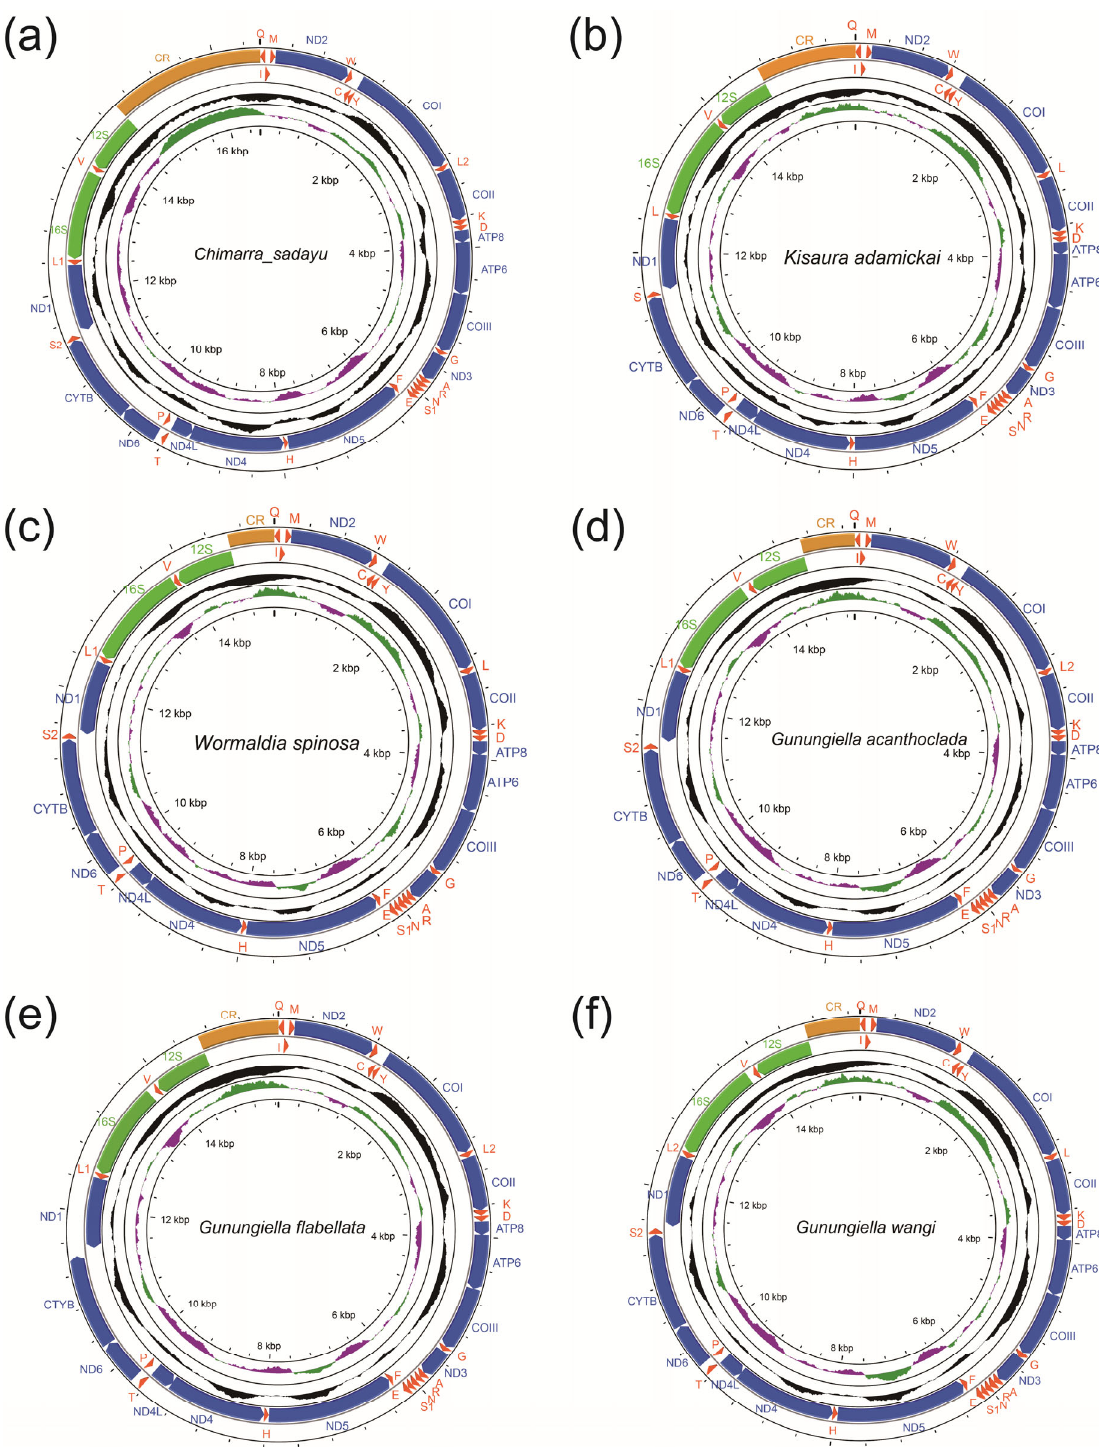
Figure 4. The mitogenome of six species of family Philopotamidae: ( a ) Chimarra sadayu ; ( b ) Kisaura adamickai ; ( c ) Wormaldia spinosa ; ( d ) Gunungiella acanthoclada ; ( e ) Gunungiella flabellata n. sp.; ( f ) Gunungiella wangi n. sp. The direction of gene transcription is indicated by the arrows. PCGs are indicated in blue, tRNA in red orange, rRNA genes in green, and CR in yellow.